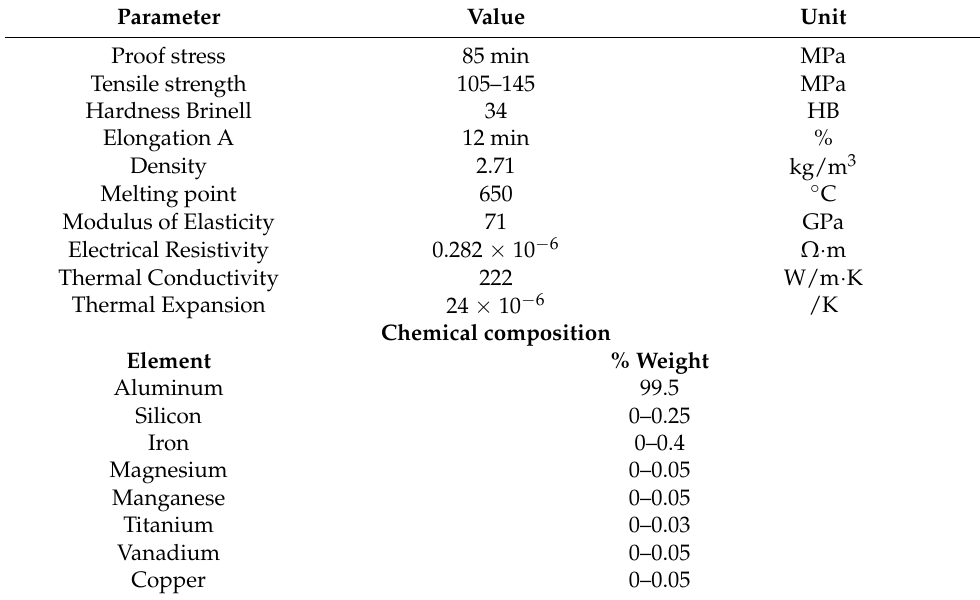
Table 1. Mechanical properties and chemical composition of aluminum alloy AW1050, used in experiments.